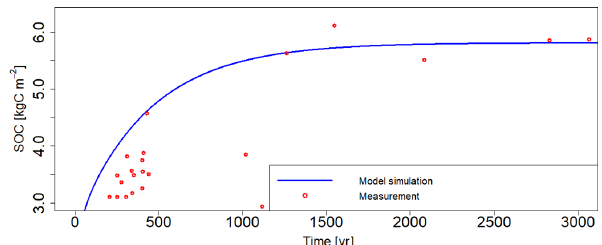
Figure 5. Measurement-based (red dots) and model-based (blue line) projections of SOC accumulation on the Finnish coast after the end of the ice